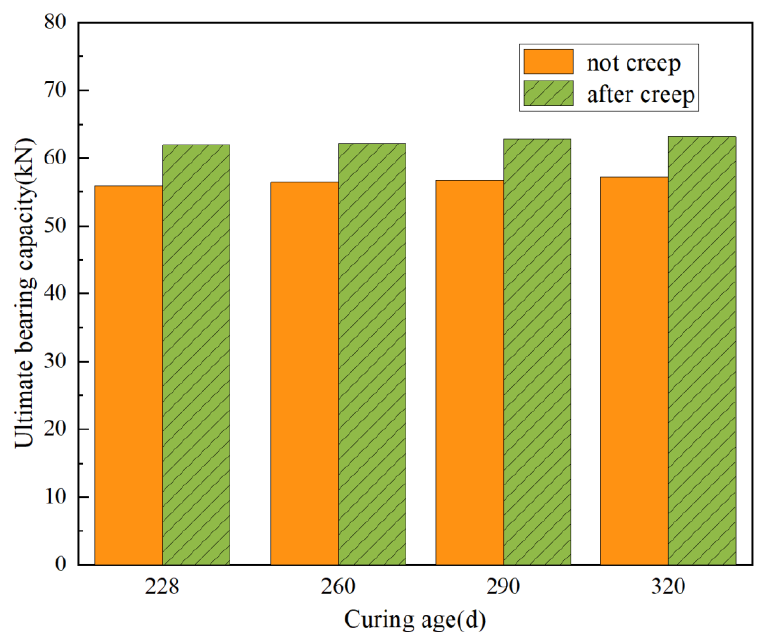
Figure 9. Ultimate bearing capacity of ceramsite concrete beams.